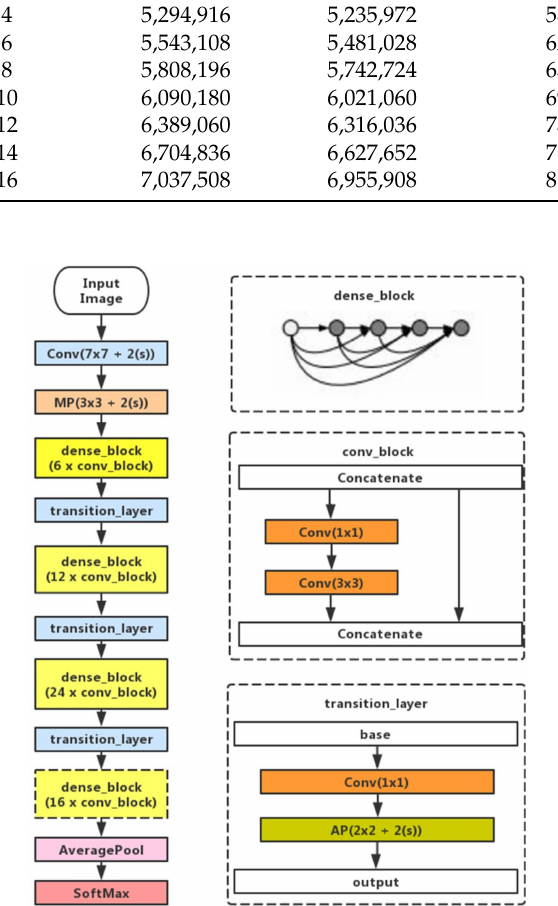
Figure 4. ( Left ) DenseNet121 architecture. ( Right ) Dense_block, conv_block and